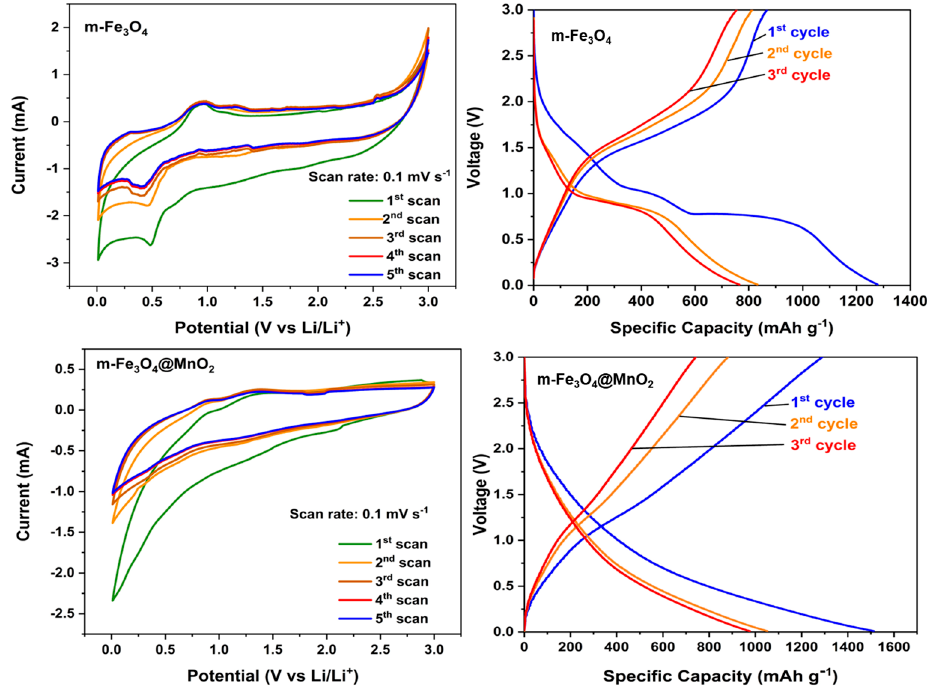
Figure 7. Cyclic voltammetry ( left ) and GCD ( right ) results of m − Fe 3 O 4 and m − Fe 3 O 4 @MnO 2 nano-composites.